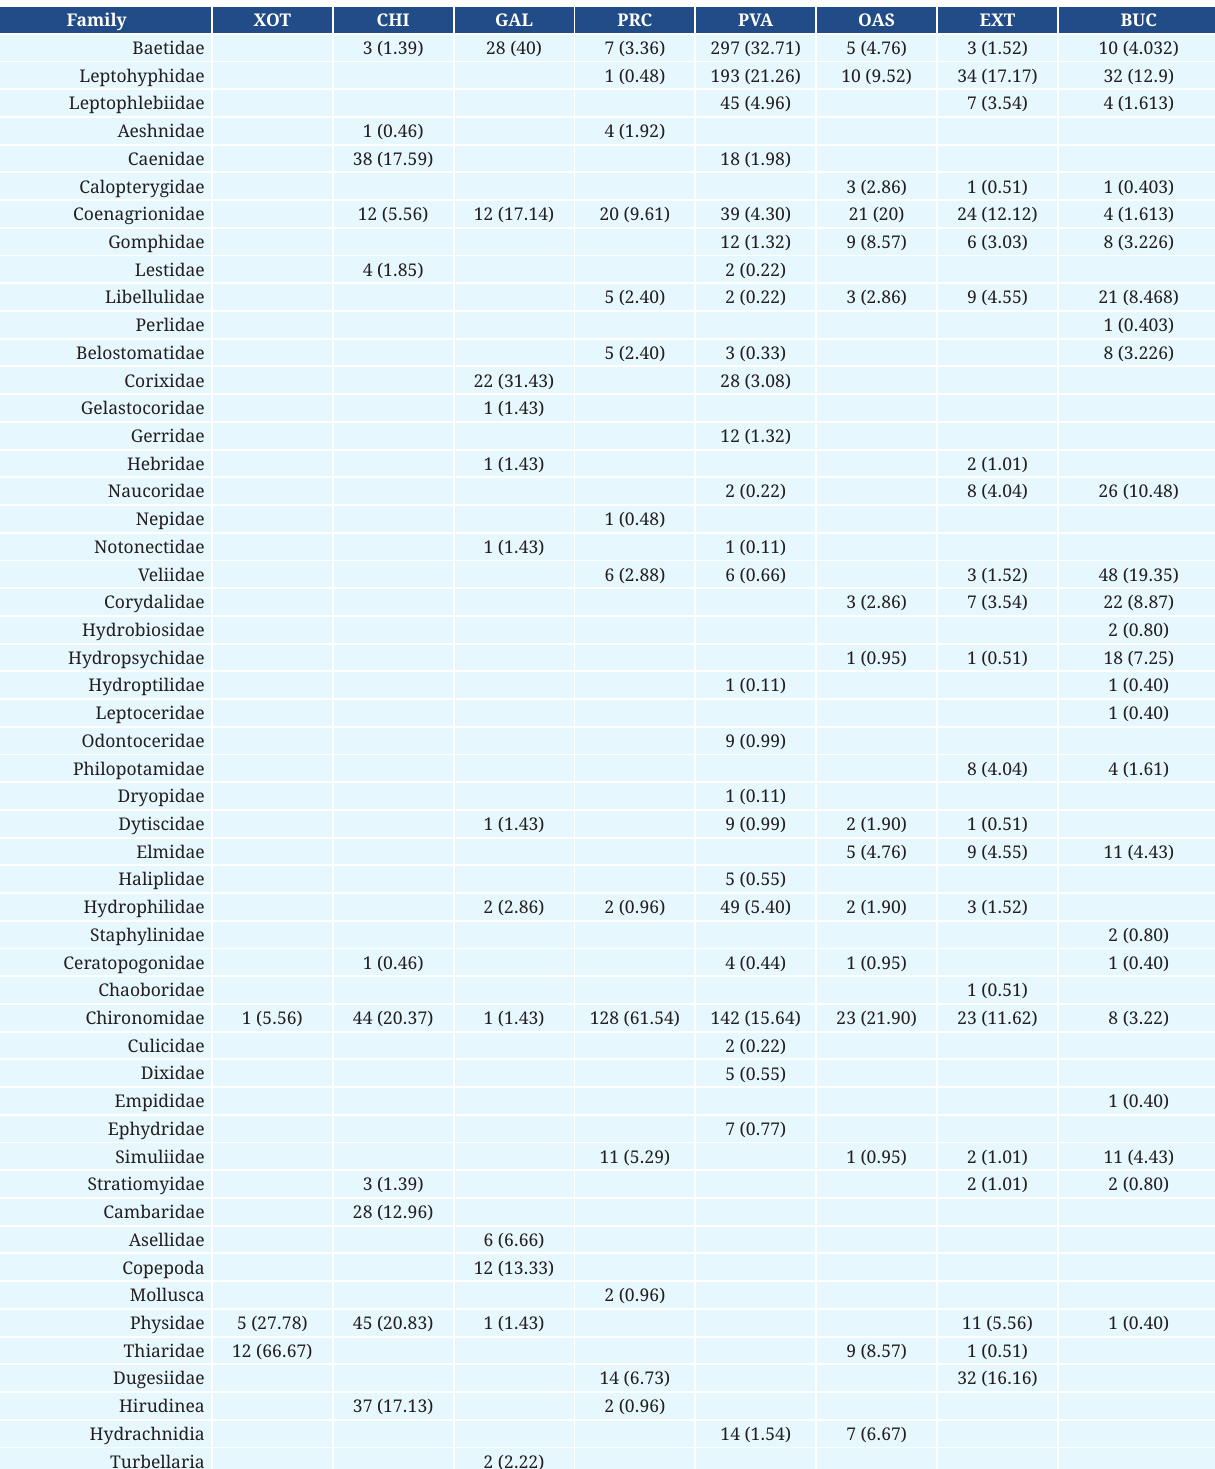
TABLE 2 | Taxonomic composition of macroinvertebrates collected in sampling sites. Numbers outside parenthesis are absolute abundance, numbers in parenthesis represent relative abundance (%). XOT=El Xote; GAL=Los Galvanes; CHI= El Charco del Ingenio; PVA=Paso